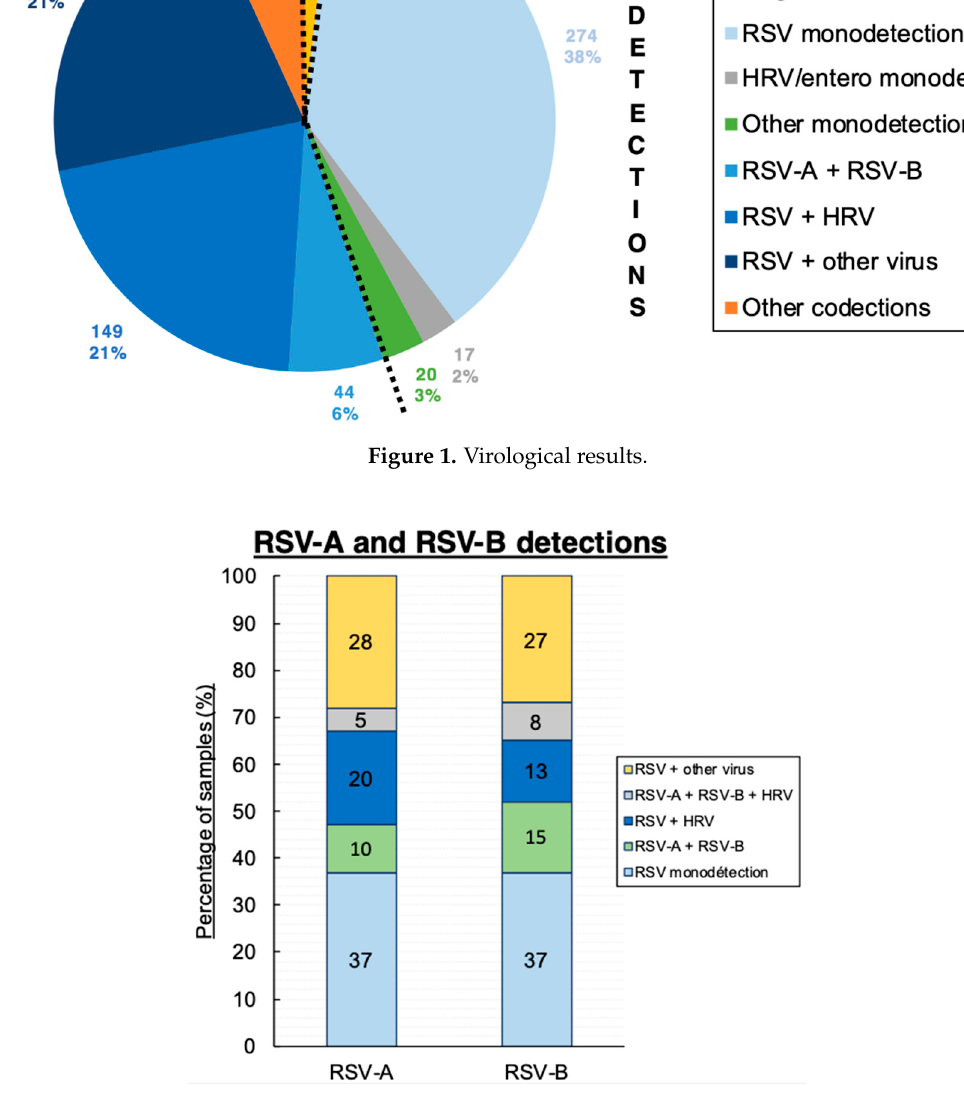
Figure 1. Virological results.